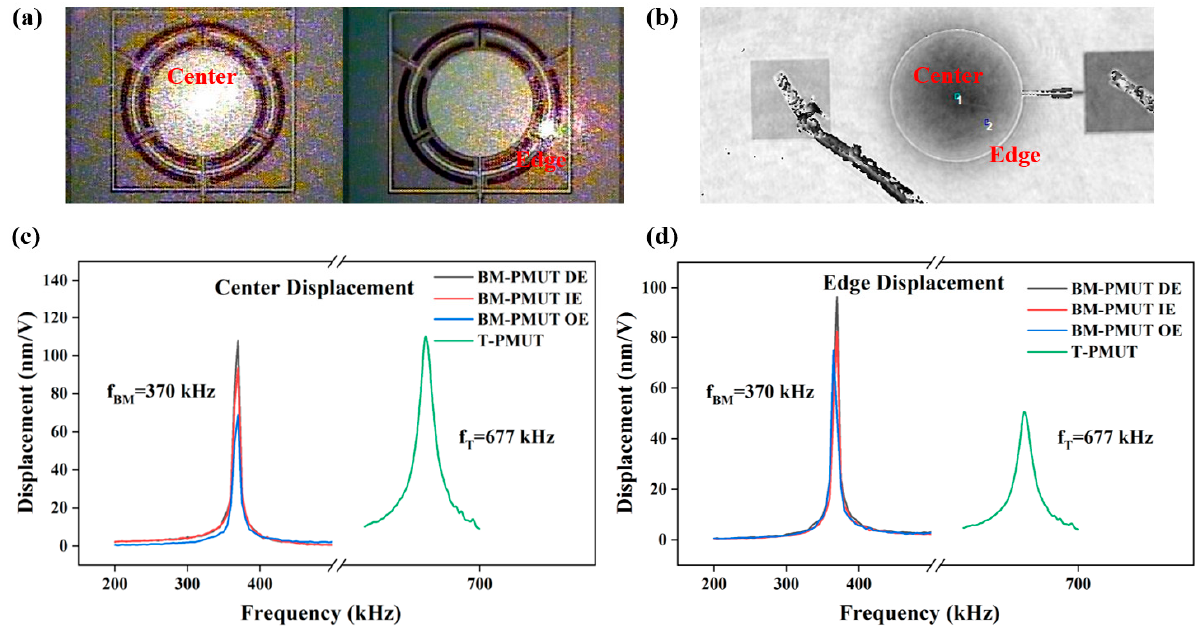
Figure 6. Sampling points on the center and edge selected for ( a ) BM-PMUT and ( b ) T-PMUT. Measured resonant frequencies and ( c ) center and ( d ) edge displacement of the BM-PMUT and T-PMUT.